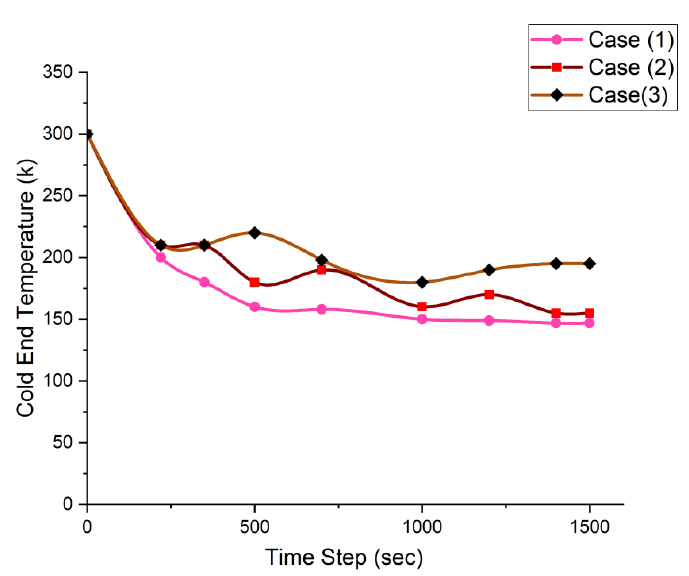
Figure 5. Between cold load temperature and cases 1, 2 and 3. Figure 5. between cold load temperature and cases 1, 2 and 3.